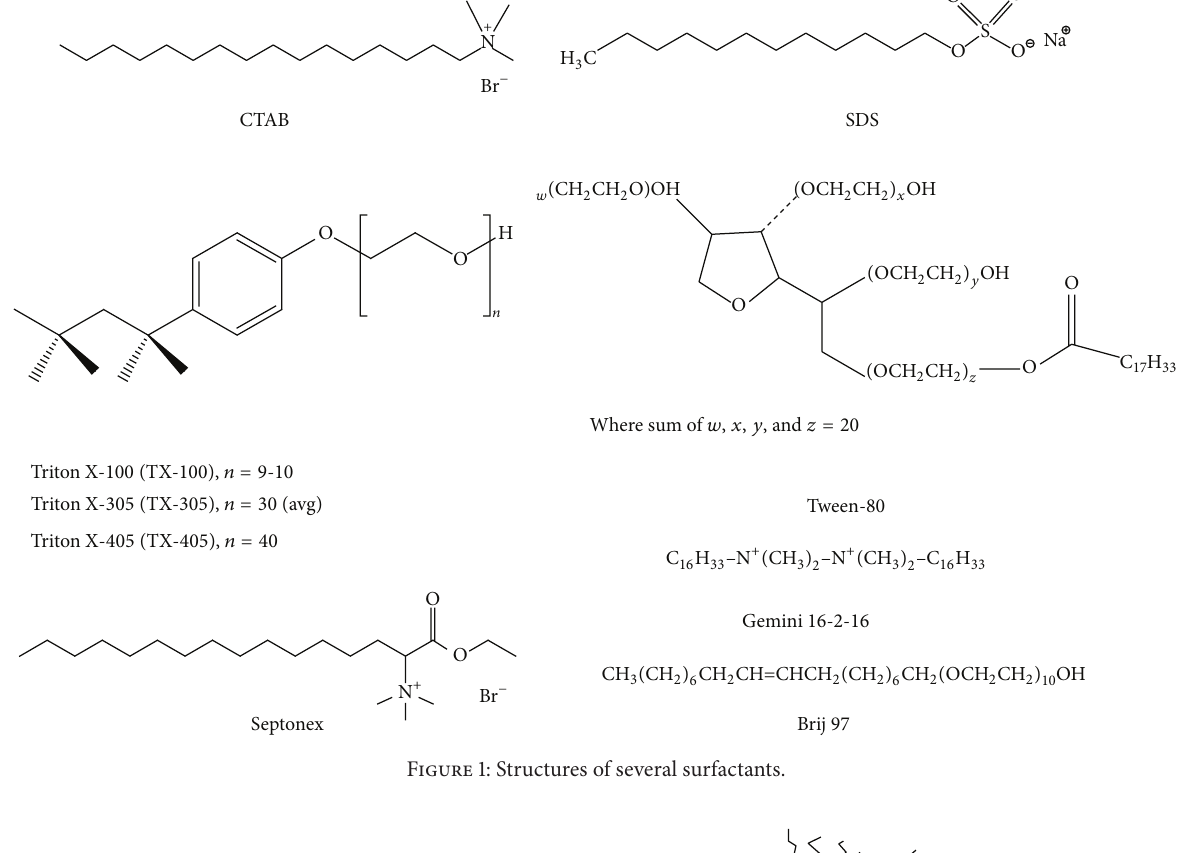
Figure 1: Structures of several surfactants.